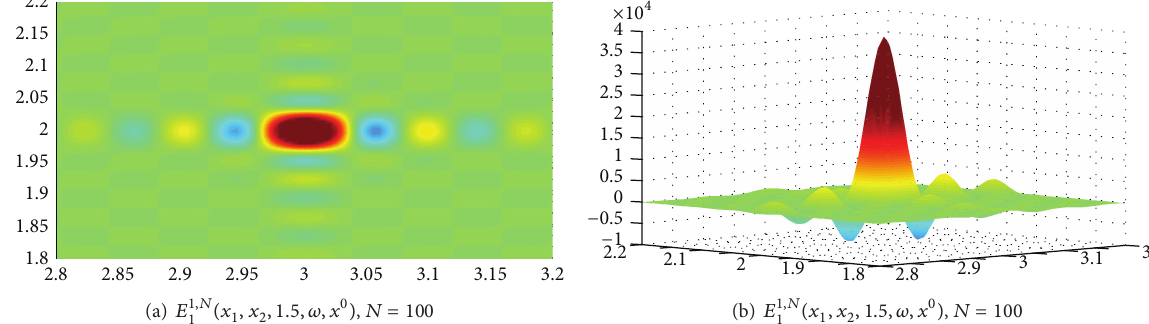
Figure 7: The first component of the first column of regularized electric Green’s